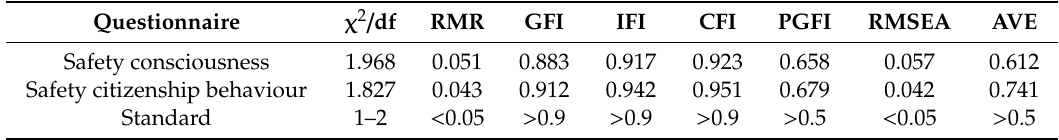
Table 8. Results of confirmatory factor analysis for